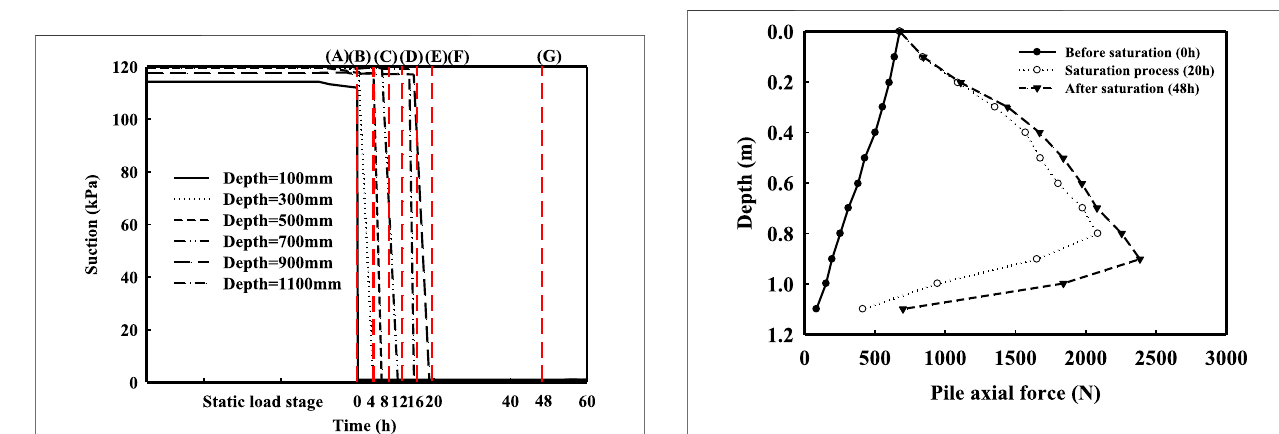
FIGURE 14 | Variations of pile axial force distribution of